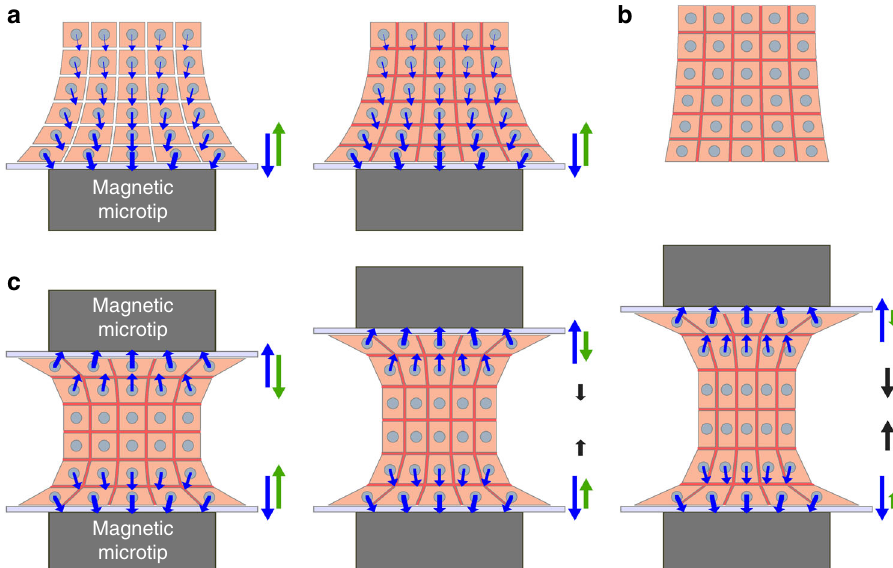
Fig. 7 Schematic view of the forces involved within the EB in the magnetic stretcher. a Formation of the EB on the magnetic microtip located below a glass wall. Each cell is subjected to a magnetic force ( blue arrow ). The total resulting magnetic force (shown on the right-hand side , also in blue ) is exactly balanced by the wall reaction force ( green arrow ). This pair of forces act like a “ clamp ” that holds mainly the “ proximal ” region of the sample, closest to the glass wall. After the magnetic contact, adhesion molecules (in red ) develop the EB cohesion, without affecting forces. b The whole aggregate can then be used as a standalone EB. c When another magnetic microtip is approached with another glass wall, the upper cell layers are “ clamped ” against the upper wall in a similar way as in a . Varying the separation of both “ clamps ” makes it possible to adjust or cycle the (tensile) strain of the main part of the EB (represented here with a thickness of only two cells for simplicity, but actually corresponding to the major part of the entire